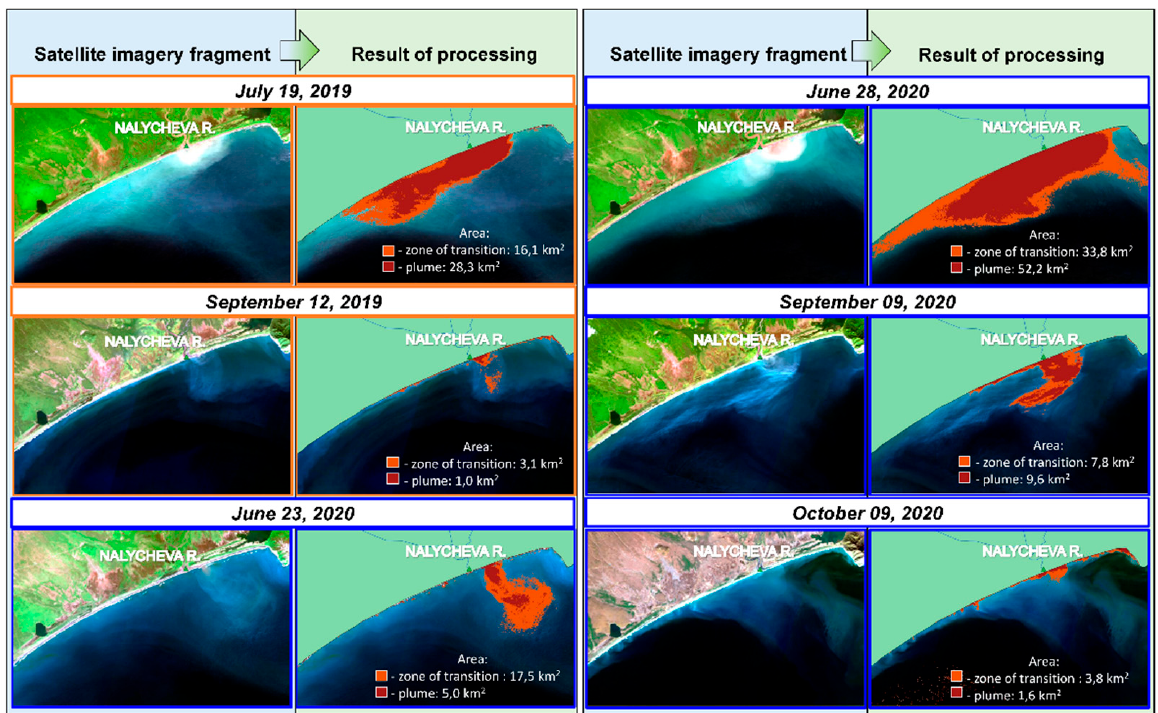
Figure 9. Maps of the Nalycheva river plume propagation areal in 2019 and 2020 (Sentinel-2A/B, TSM concentration spatial distribution thresholding, the plume’s “core” and “transition zone” are identified).